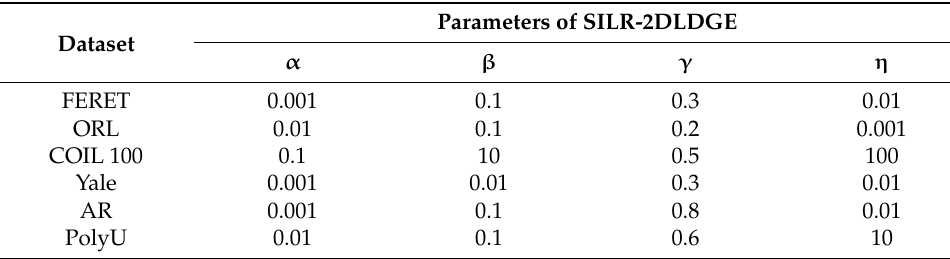
Table 1. Parameter values of the SILR-2DLDGE algorithm on different datasets. Parameters of Dataset